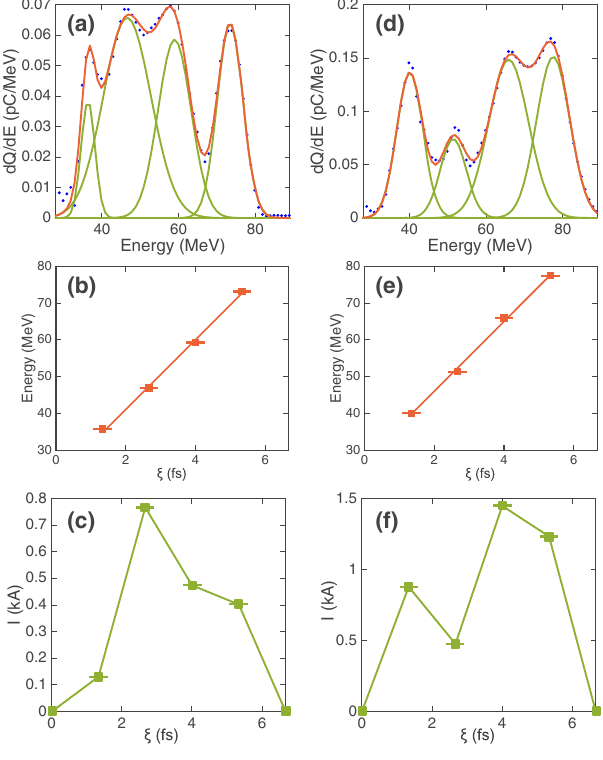
FIG. 6. (a) shows a typical deconvoluted energy spectrum (the blue dots) fitted by four Gaussian peaks (the solid green lines), where each peak represents a single beamlet. The red line is the superposition of the fitted peaks. (b) The recovered longi- tudinal phase space. (c) The recovered current profile. The deconvoluted energy spectrum, the recovered longitudinal phase space and the recovered current profile for another shot with a higher density [ 1 . 31 × 10 19 cm − 3 versus 1 . 10 × 10 19 cm − 3 in (a) – (c)] are shown in (d) – (f), respectively. The error bars in (b), (d), (e), and (f) represent for the uncertainty of bunchlet separation (see main